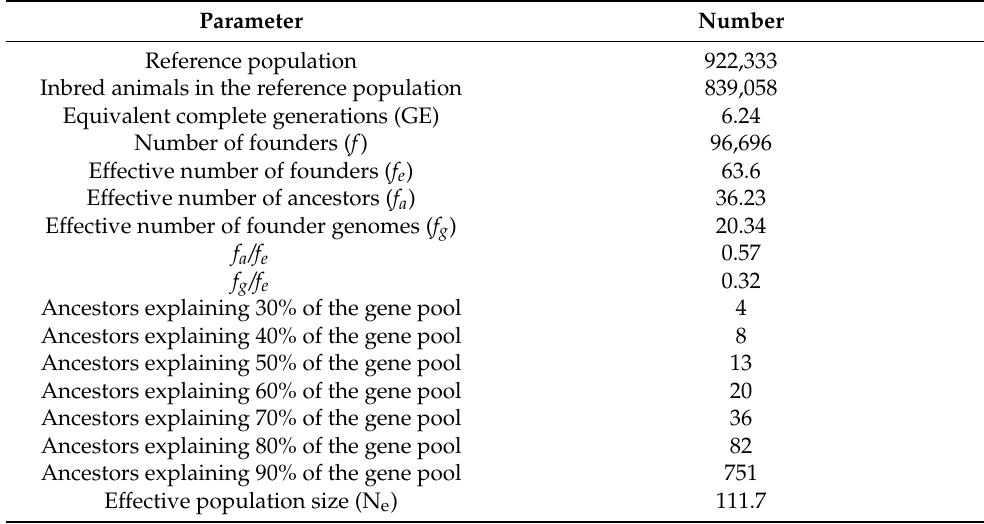
Table 1. Results of the pedigree analysis for measures of genetic diversity for the German Brown population of the birth years from 1990 to 2014.